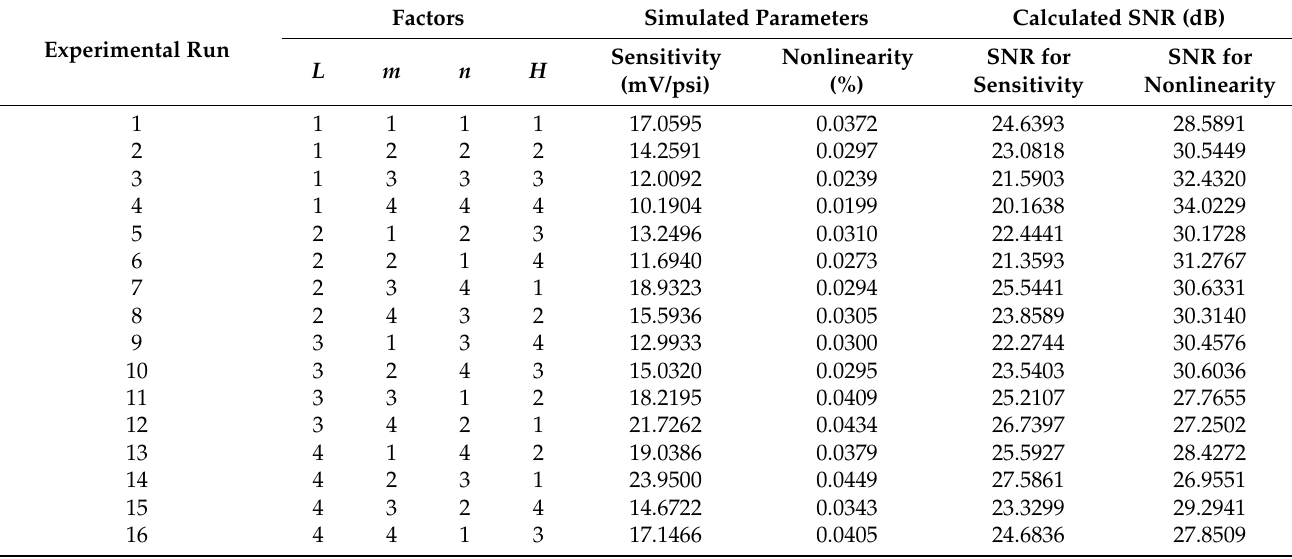
Table 2. Simulation results and associated SNR for sensitivity and nonlinearity of the tested pressure sensors.